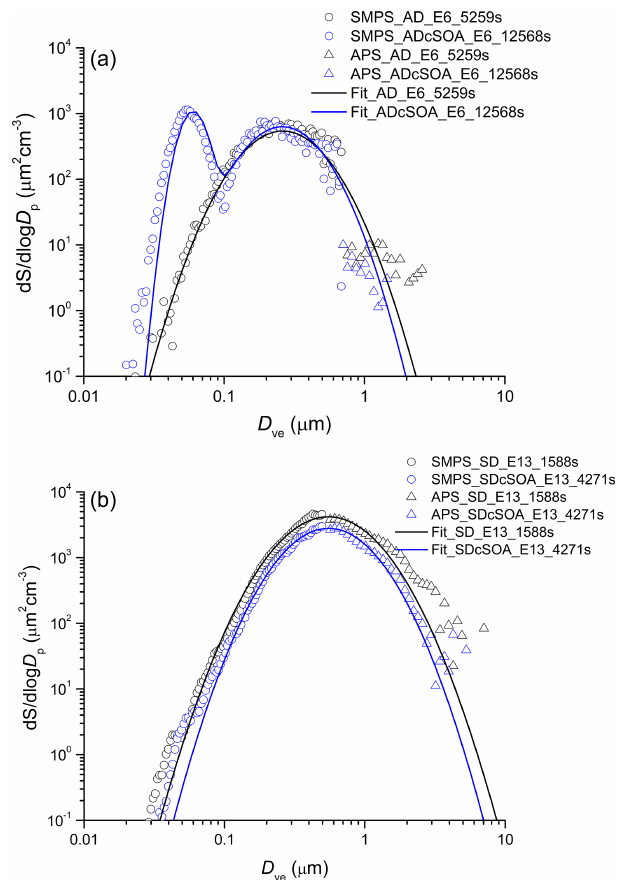
Figure 3. Same as Fig. 2 but for surface area distribution as a func- tion of volume-equivalent